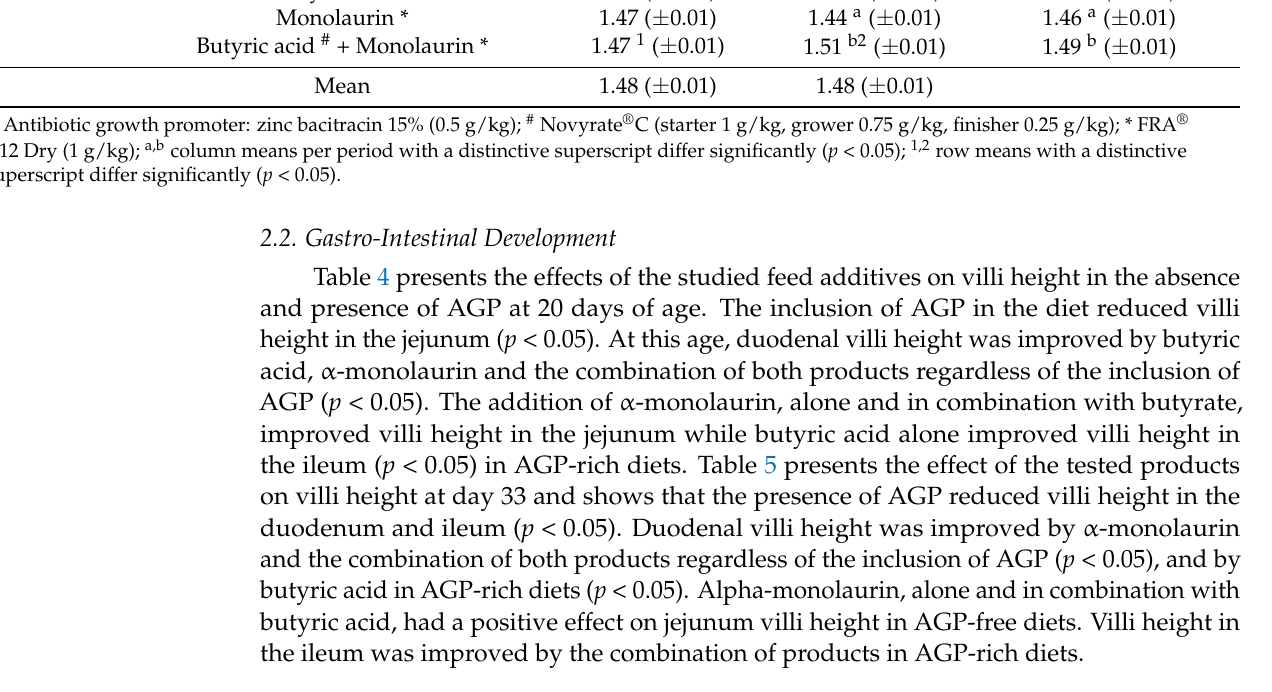
Table 4. The effect of the butyric acid and α -monolaurin, with and without the inclusion of antibiotic growth promoters, on the villi height ( µ m) of the duodenum, jejunum and ileum of broilers at 20 days of age ( ± standard error of the mean). Intestinal